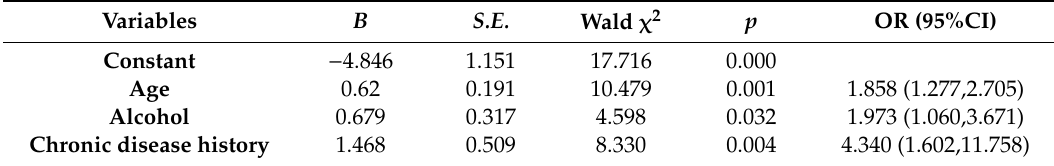
Table 4. The results of the logistic regression on the pain / discomfort dimension.